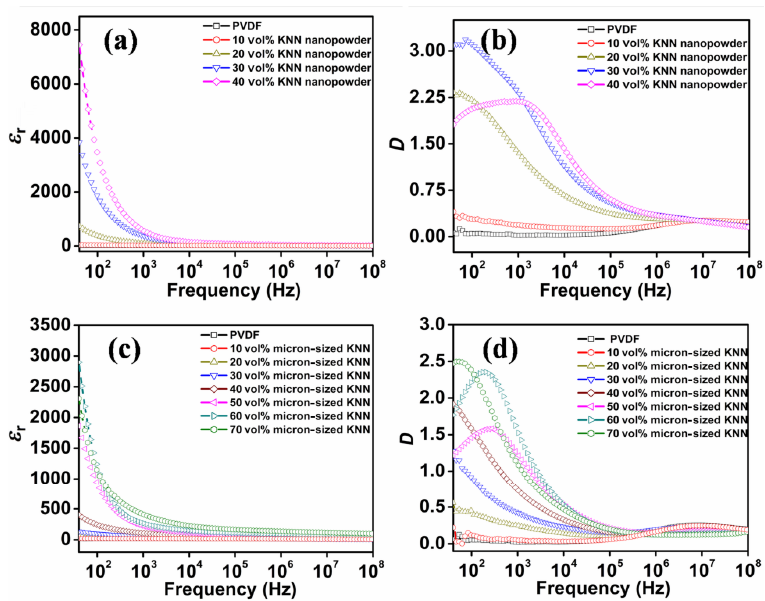
 ) and loss ( D ) for (a, b) PVDF with KNN nano-sized crystallites of different Fig. 6 Frequency dependent dielectric constant ( r volume fraction and (c, d) PVDF with KNN micron-sized crystallites of different volume fraction at room temperature.